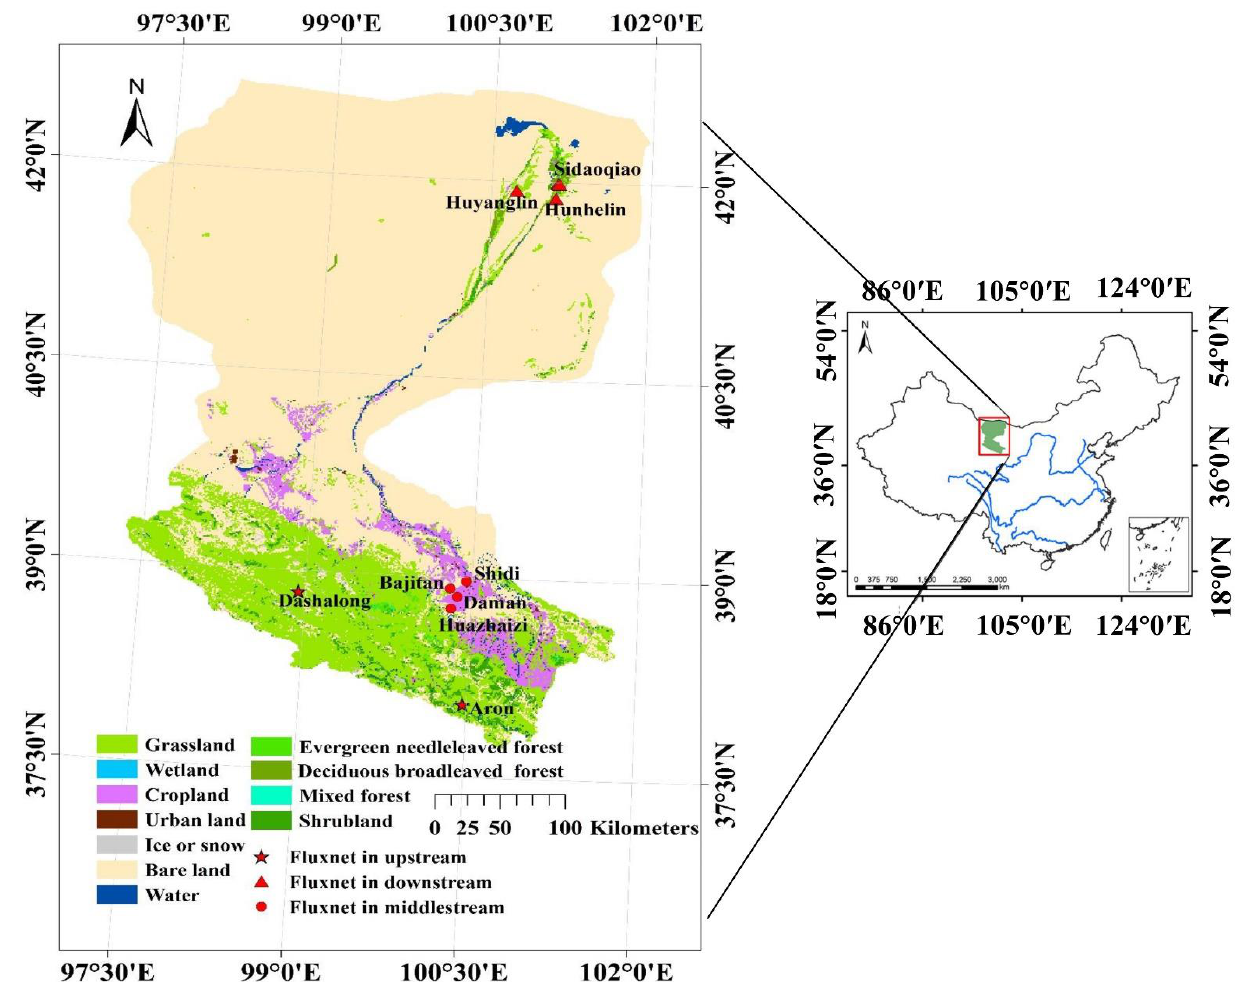
Figure 1. Location of the Heihe River Basin and nine carbon flux observation stations. A 30 m GPP product with a temporal resolution of 8-day in the study area was also used in this paper to compare the accuracy when validating at field scale and at footprint scale. This GPP product was generated by using a downscaled model based on MODIS and Landsat data [43]. Specifically, fraction photosynthetically active radiation (FPAR) and leaf area index (LAI) with a spatial resolution of 30 m and a temporal resolution of 8 days were firstly generated from a downscaled method, and then 30 m GPP were obtained by using a light use efficiency model